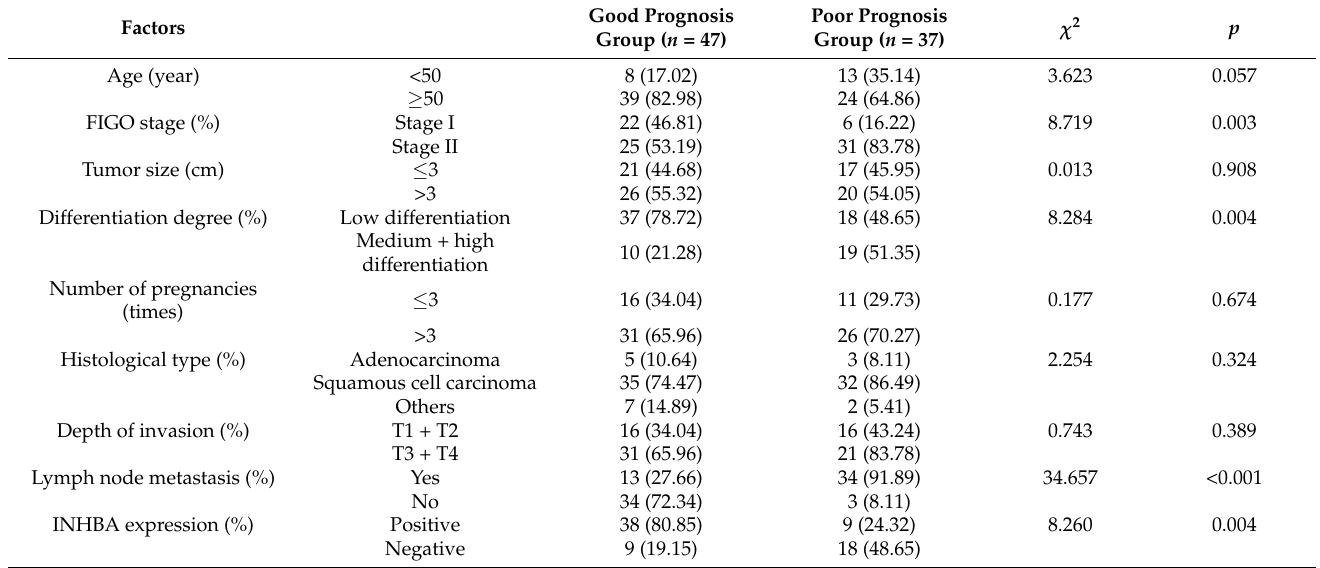
Table 4. Univariate analysis of clinical prognosis.